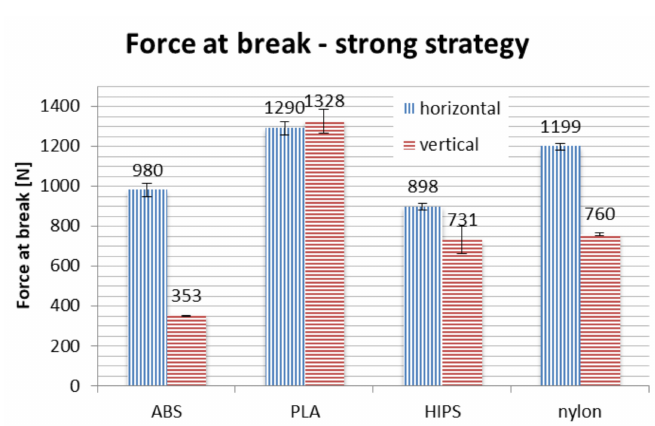
Figure 17. Strength of manufactured orthoses—accura strategy.